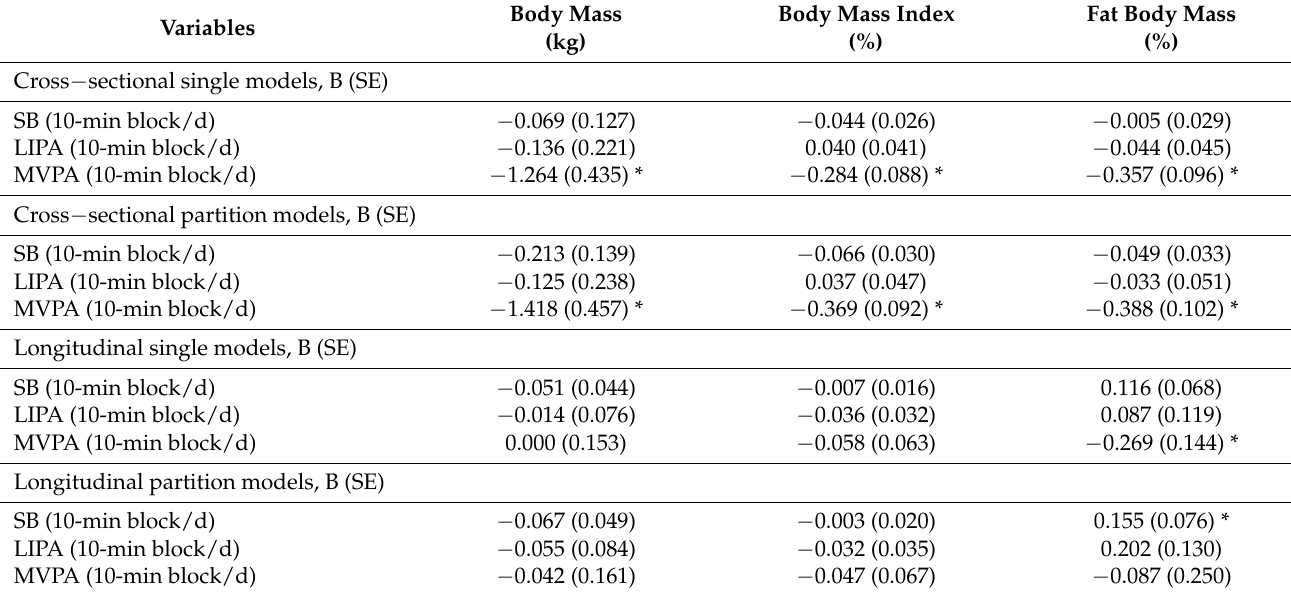
Table 3. Single and partition models assessing the correlations of physical activity intensities and obesity indices.